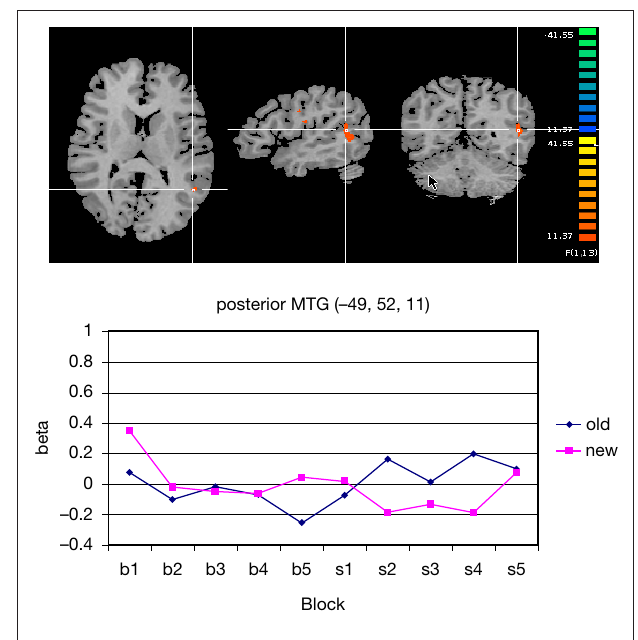
FIGURE 7 | Signifi cant confi guration by change interaction in left temporo-parietal junction area. (A) The TPJ-activation is marked by the cross hair. Left hemisphere is presented on the right. (B) Group signal strength as a function of condition and block. The graph shows beta values, signifying the amplitude of the modeled BOLD-response. Old: repeated trials, new: novel trials.